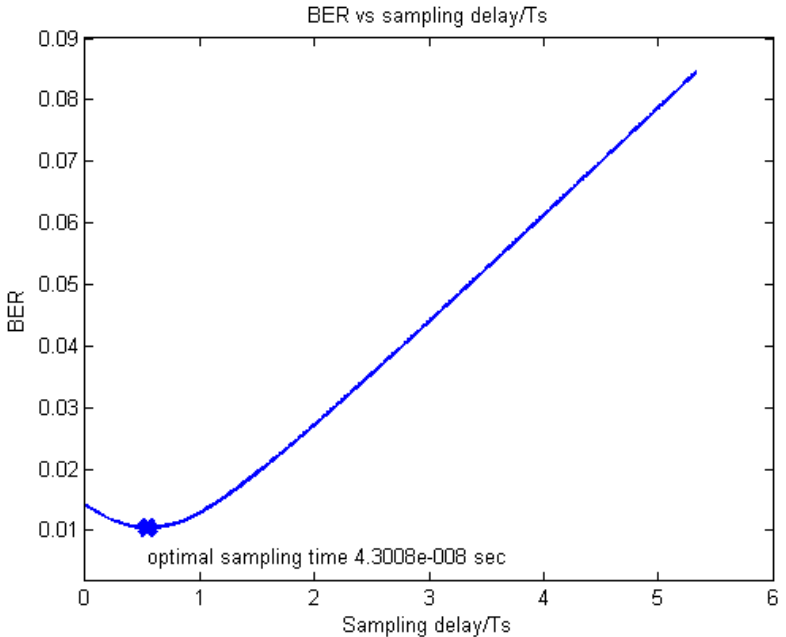
Figure 6. Estimated and simulated BER vs. (optimal) sample time for the EPA LTE FDD downlink.